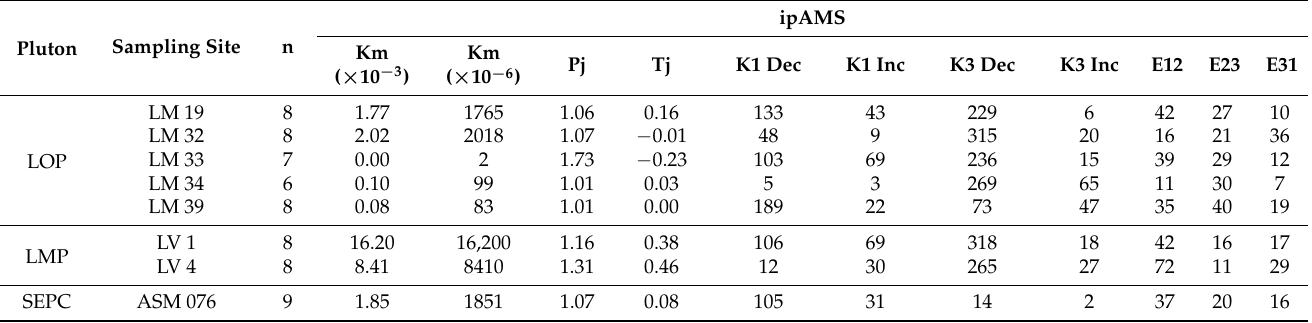
Table 1. ipAMS data for studied granites (n—number of samples; the ipAMS measurements were performed according to a specimen coordinate